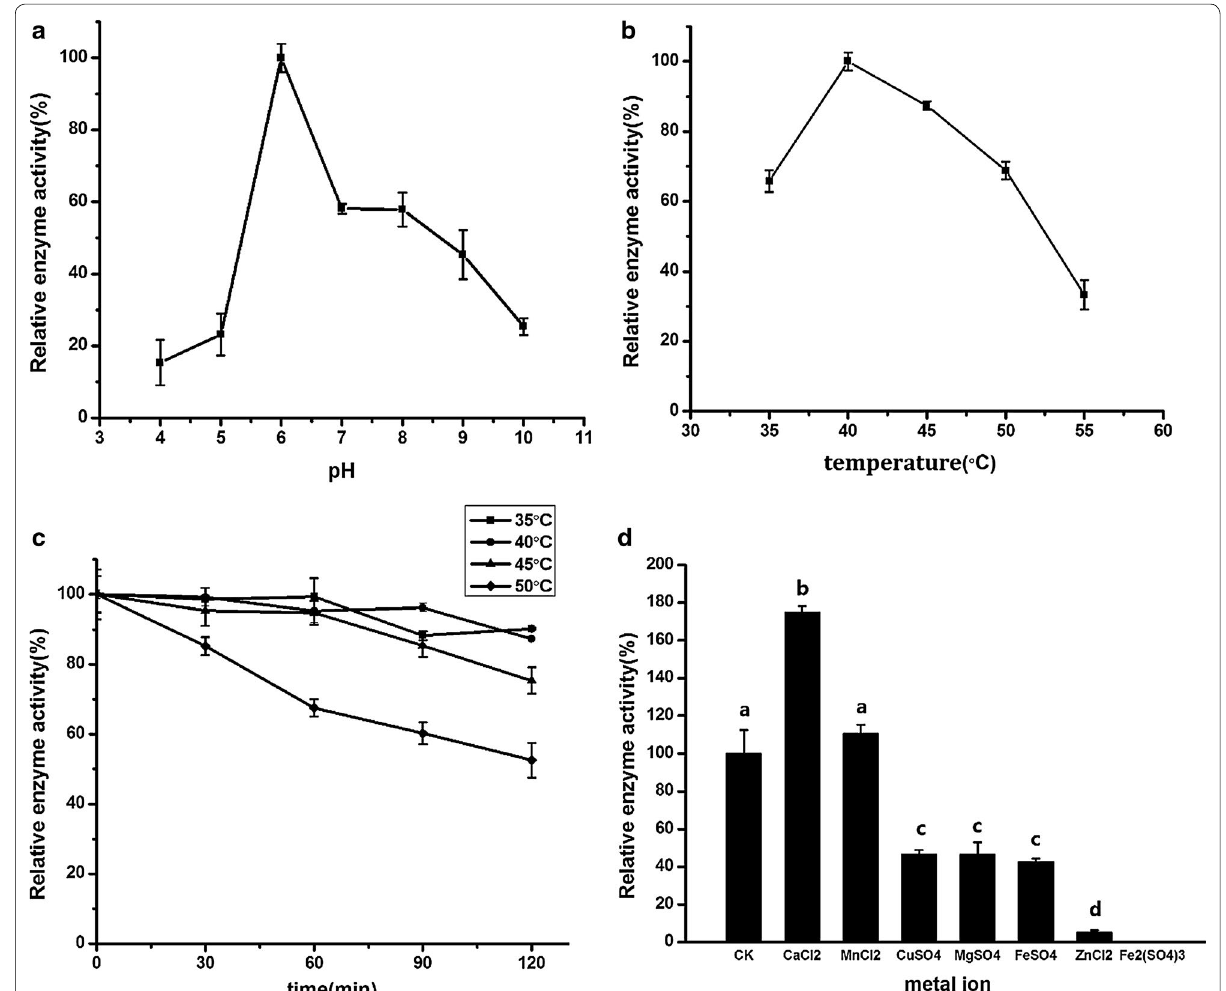
Fig. 5 The effects of pH value ( a ), temperature ( b ), incubation time ( c ) and metal ion ( d ) on the activity of pectinase. The pH optimum of proteinase was studied from 3 to 11. The temperature optimum was studied from 35 to 60 °C. Temperature stability was determined by holding the enzyme at 35–50 °C for 120 min. Metal ions included Mn 2 + , Mg 2 + , Ca 2 + , Cu 2 + , Zn 2 + , Fe 2 + and Fe 3 + . Values represent the mean with different letters indicate significant differences ( p <